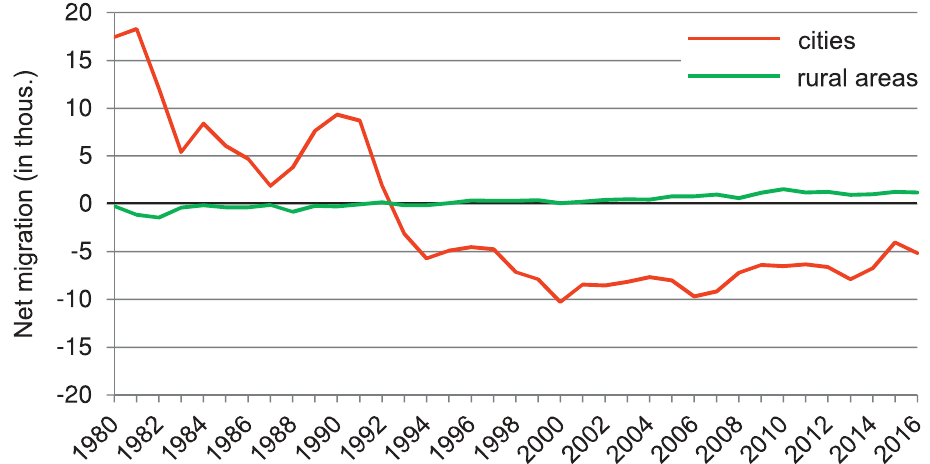
Fig. 4. Net migration for cities and rural areas of the Katowice conurbation, 1980–2016 (Source: own elaboration based on Local Data Bank of the Central Statistical Office; Rocznik Statystyczny Województwa Katowickiego 1981,–1995, WUS,